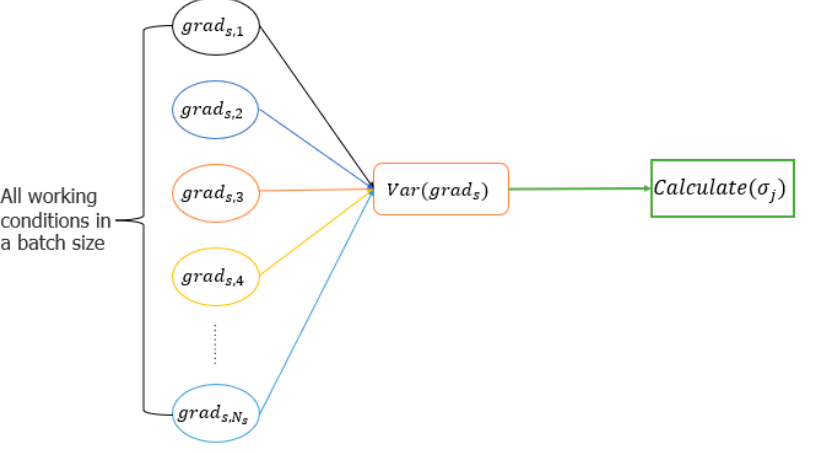
Figure 3. The gradient variance of all samples in the batch replaces the gradient variance of each sample.